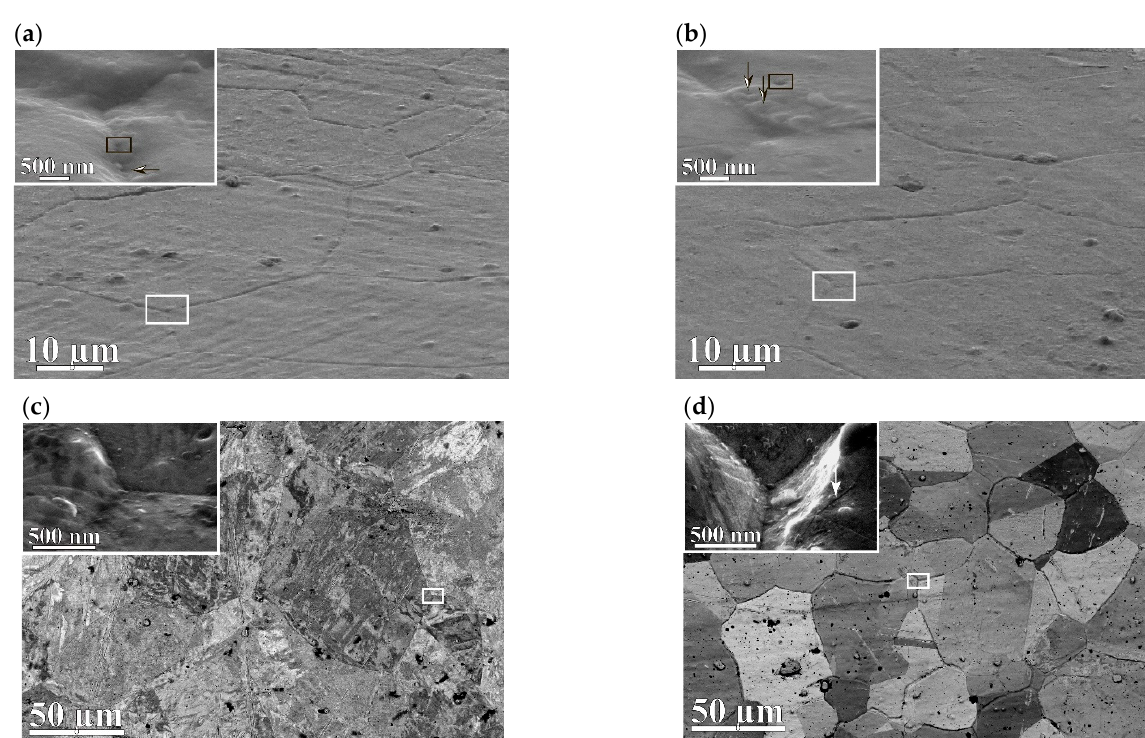
Figure 5. Morphology of the membranes surface: ( a )—5 wt.% Pb; ( b )—20 wt.% Pb before hydro- genation; ( c , d )—5 and 20 wt.% Pb, after hydrogenation, respectively. Arrows of the inserts indicate funnel–shaped defects.